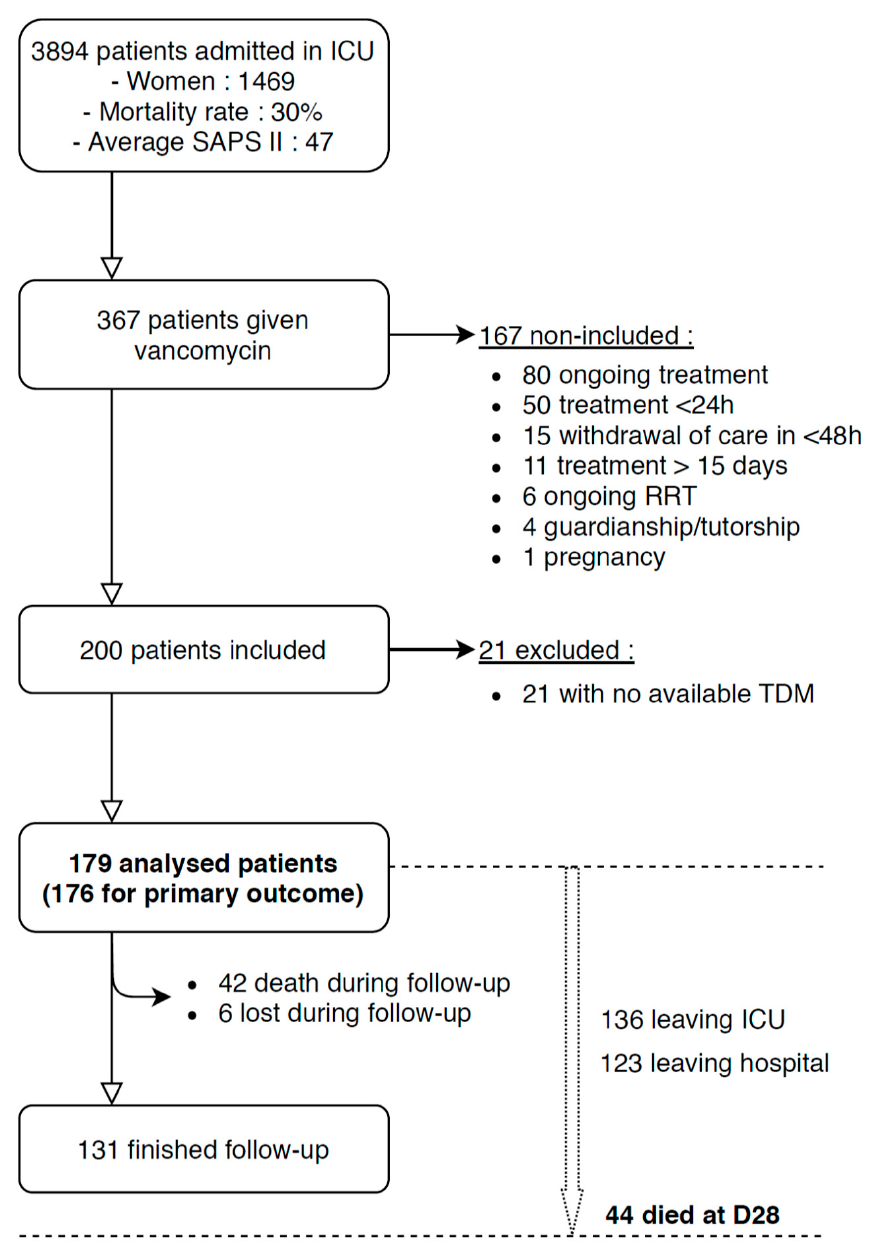
Figure 1. Flow chart showing patient inclusions and exclusions. TDM: therapeutic drug monitoring. Follow-up was the 15 consecutive days after vancomycin initiation. D1 was the day of vancomycin initiation.